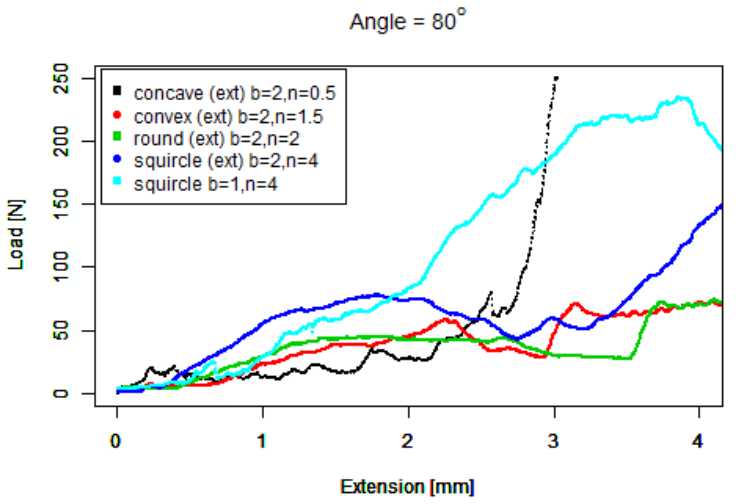
Figure 17. Steeper gradients against 80 ◦